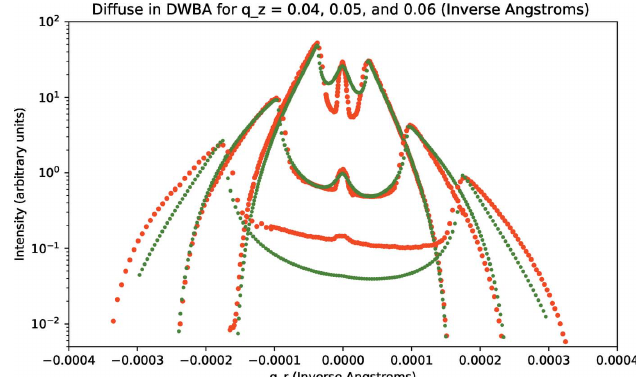
Figure 11 Rough sample: rocking data (red) and calculated fit (green) for q z = 0.04, 0.05, 0.06 A˚ (cid:2) 1 . The offset between the three q z cases is arbitrary and chosen for clarity. The fit invokes only calculated diffuse scattering in the